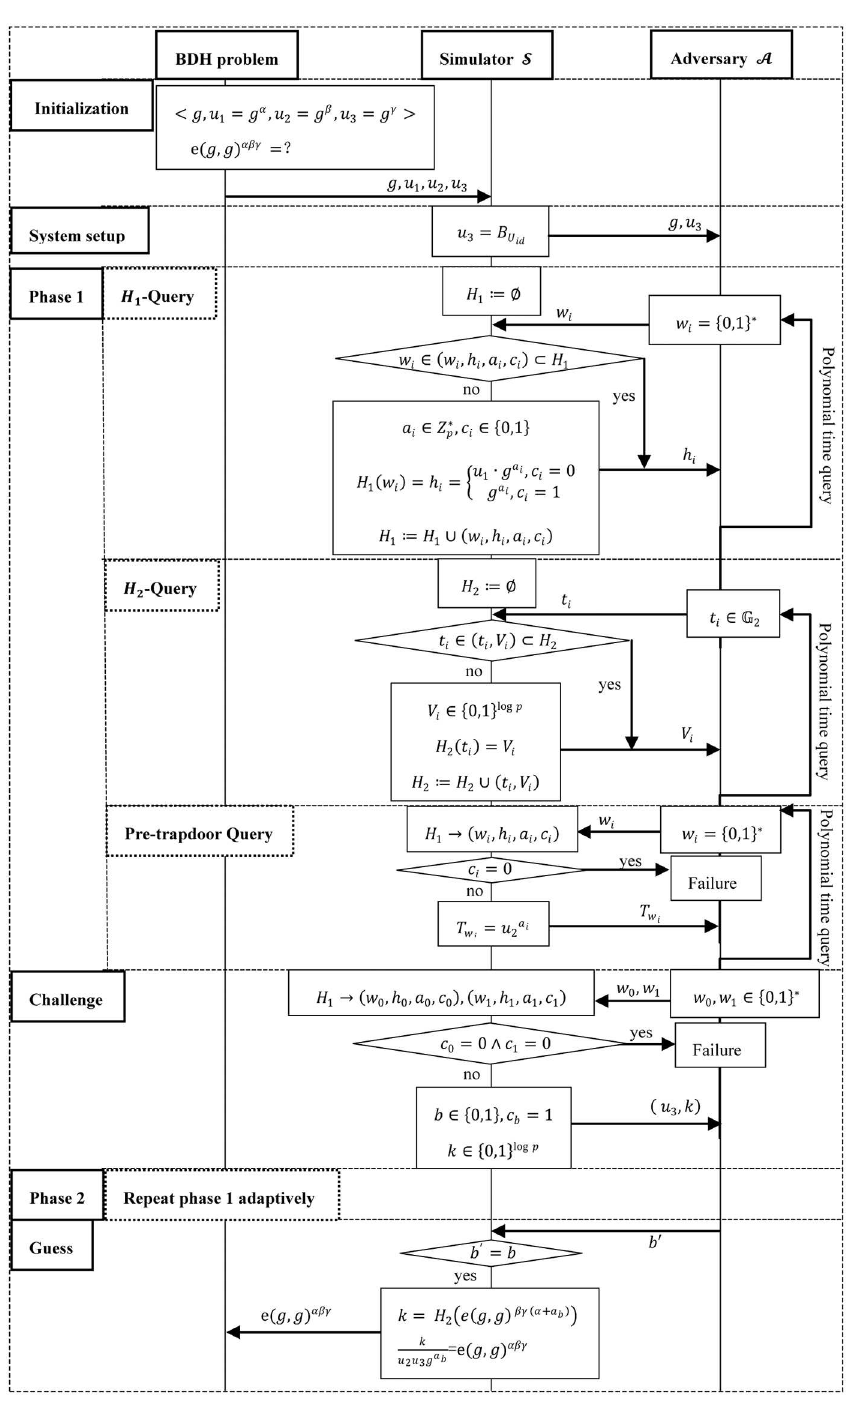
Fig 3. Flowchart of attack model